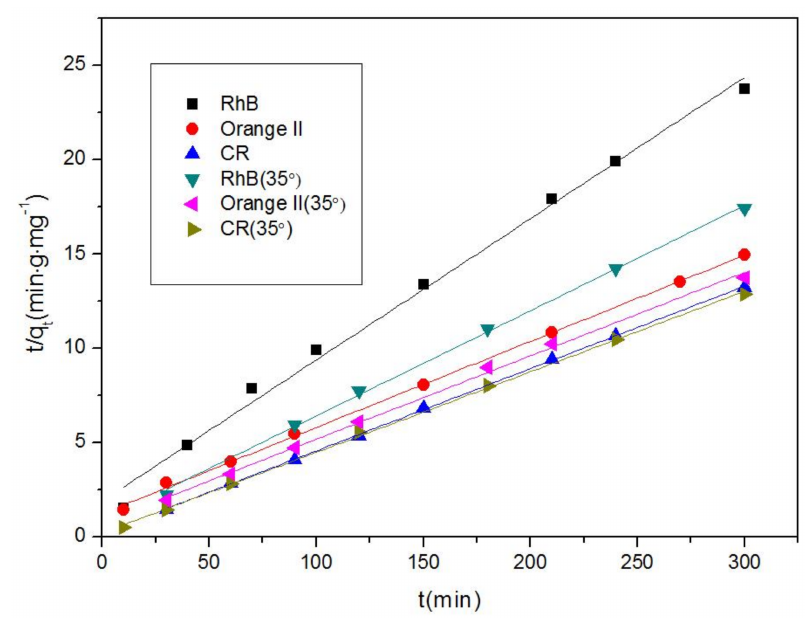
Figure 8. Pseudo-second-order plots of dye adsorption over